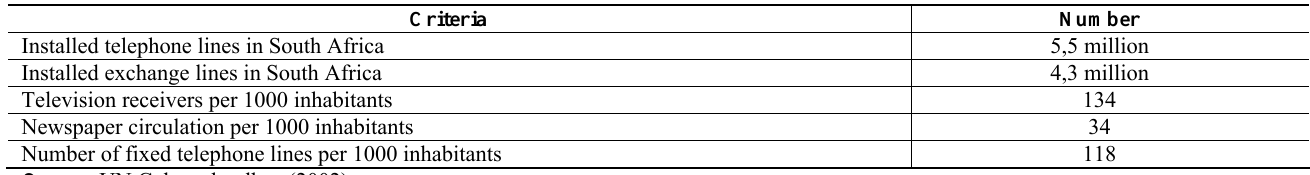
Table 8: Main connectivity indicators of South Africa